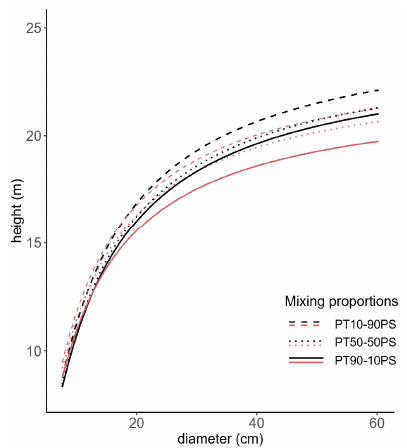
Figure 2. Comparison of h-d curves for the two species, black lines for Maritime pine and red lines for Scots pine, under different mixing proportions, PT90-10PS (solid lines, 90% Maritime pine–10% Scots pine), PT50-50PS (light dashed lines, 50% Maritime pine–50% Scots pine) and PT10-90PS (heavy dashed lines, 10% Maritime pine–59% Scots pine). Results are displayed for a mixed stand with Ho = 20 m, dq = 30 cm, and Do = 40 cm.